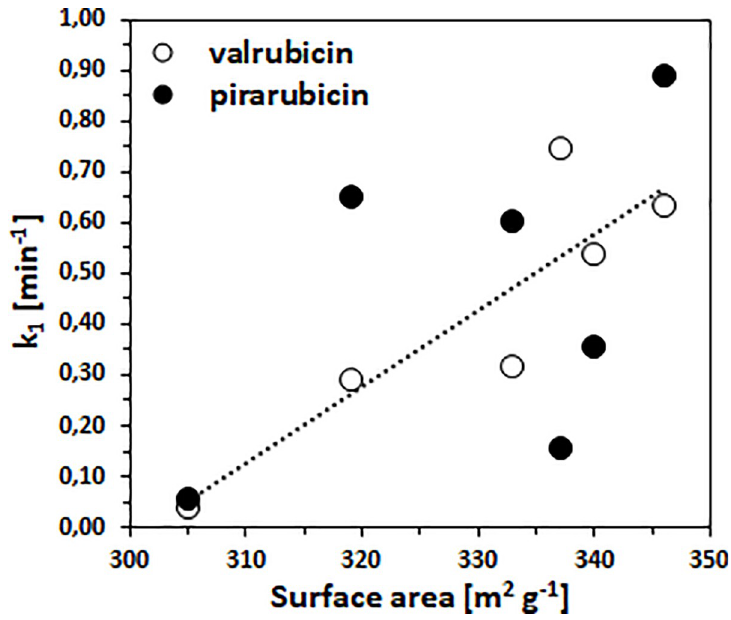
Fig 11. Dependence of k 1 (min -1 ) versus surface area (m 2 g -1 ) of prepared TiO 2 samples.